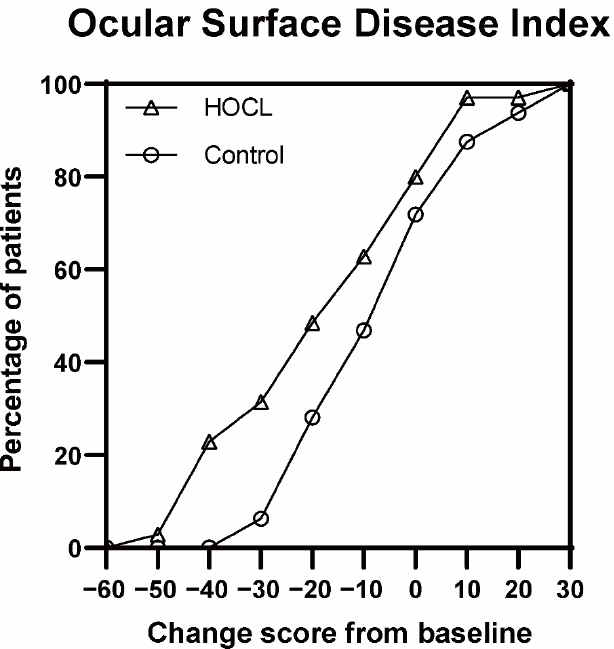
Figure 3. Cumulative distributions of the primary endpoint in the study of 0.01% hypochlorous acid (HOCL) for blepharitis. Shown is the cumulative distribution of the change score from the baseline of the ocular surface disease index (OSDI). Proportion of patients in the HOCL group show more changes than the control group.